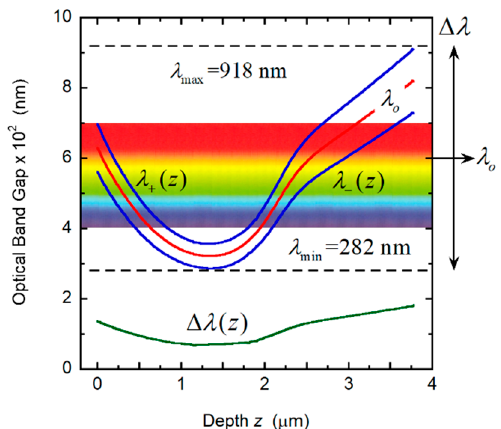
Figure 10. Variation with depth through the cuticle of the local photonic band gap ( Δ λ ( z )) and of its limits ( λ + ( z ) and λ − ( z )). The effective values of the central position of the band and its width are indicated as λ o and Δ λ .